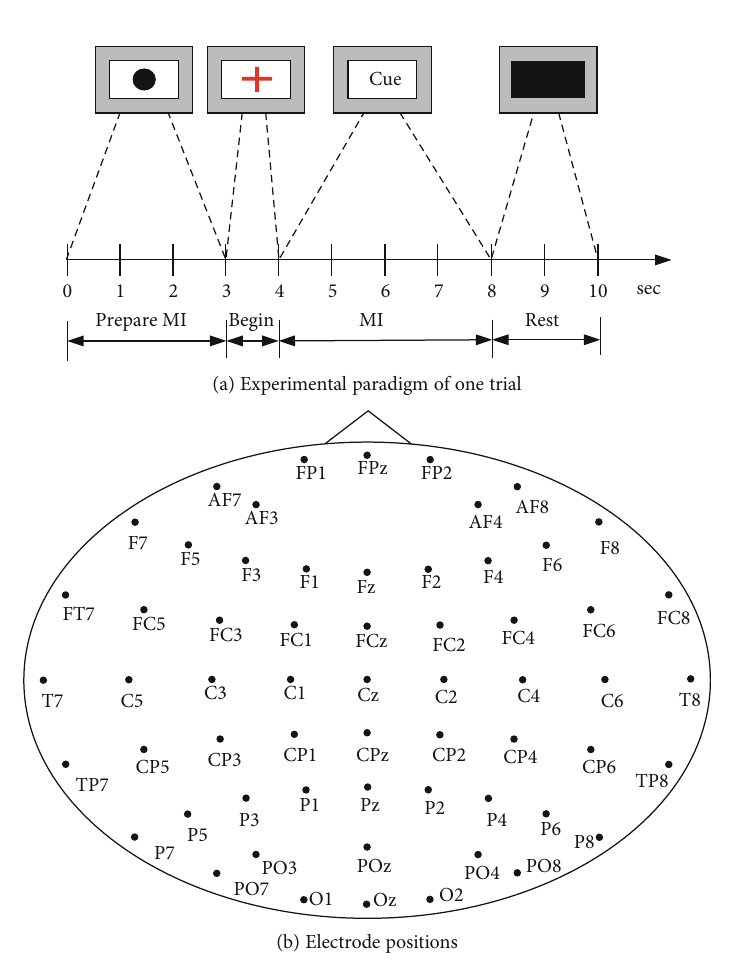
Figure 3: Experimental paradigm and electrode